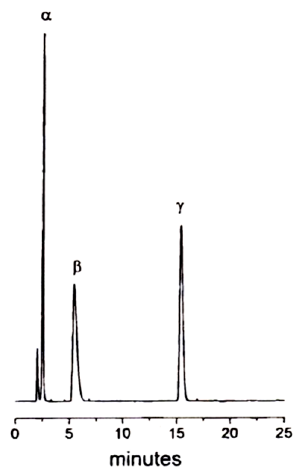
Figure 25. Separation of α -, β - and γ -cyclodextrins (CD6, CD7, CD8) on immobilized C 60 by HPLC. 250 × 1.8 mm I.D. stainless steel column packed with [60]fulleropyrrolidine-based silica (Hypersil, 5 μ m), eluent: 0.25 mL/min water/methanol/tetrahydrofuran (80/10/10 for 3 min and then linear gradient to 40/30/30 in 25 min, at 25 °C. Reprinted with permission from [105]. Copyright (1997) American Chemical Society.